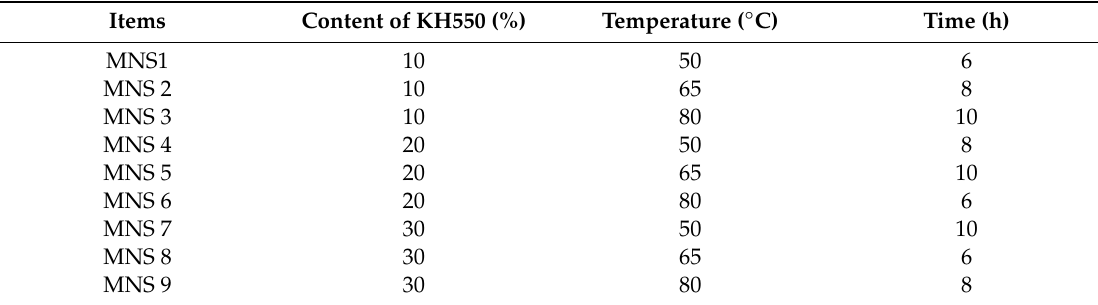
Table 2. Technological parameters of nano-SiO 2